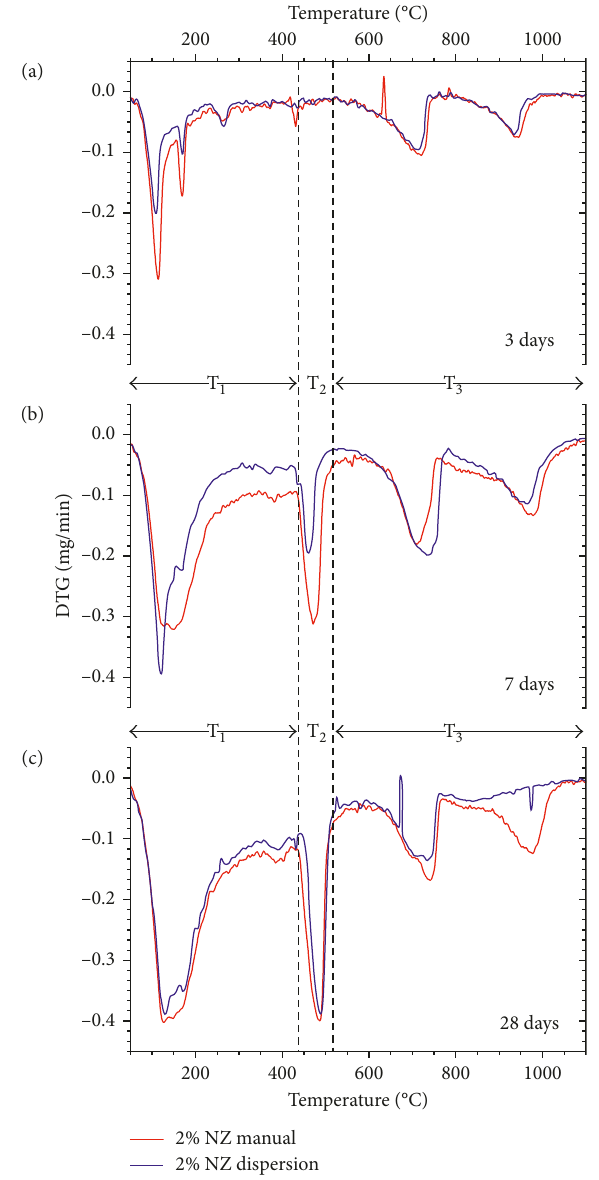
Figure 1: DTG-T a analysis for cement paste with 2 wt.% of nanozinc (NZ) for (a) 3, (b) 7, and (c) 28